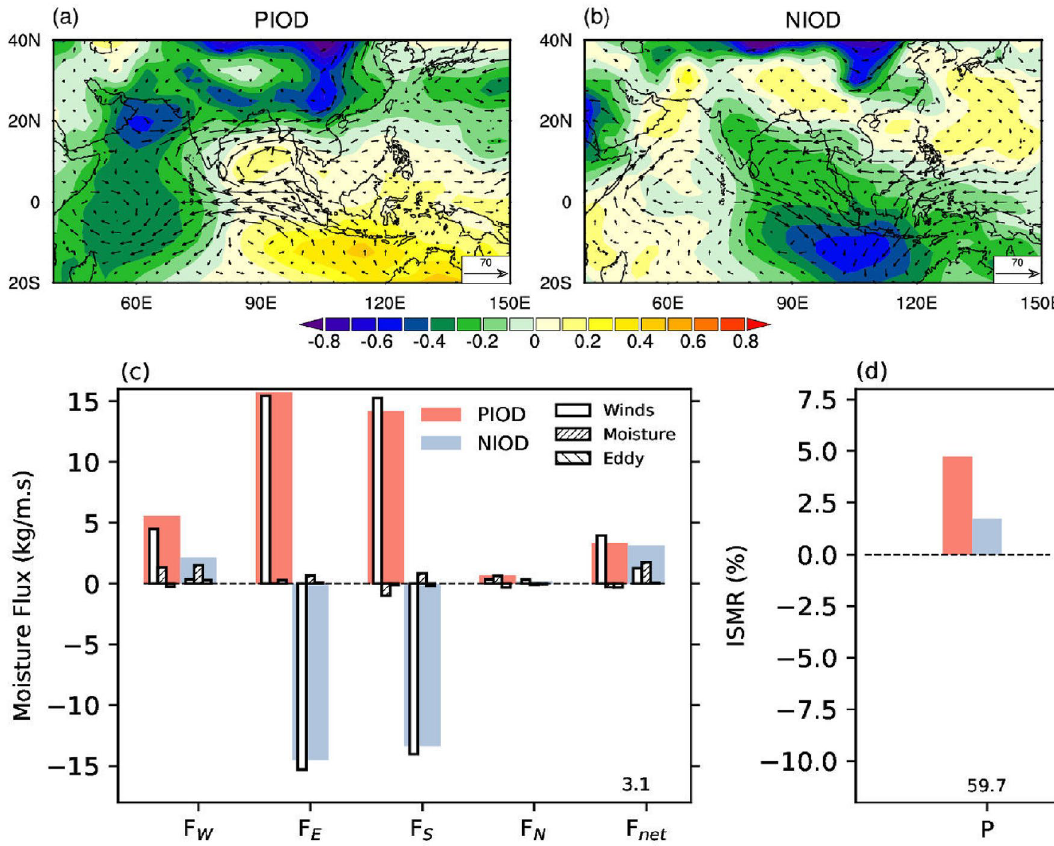
Figure 4. The teleconnection to Indian Ocean Dipole (IOD). Composite change in the anomalous surface pressure (hPa) and vertically integrated moisture flux vector ( kgm − 1 s − 1 ) during ( a ) positive (PIOD) and ( b ) negative (NIOD) phases. ( c ) Shows the vertically integrated moisture flux anomalies and its decomposition along the four boundaries (west ( F W ), east ( F E ), south ( F S ), and north ( F N )) and net moisture convergence ( F net ) over region marked as ABCD in Fig. 1a, for PIOD (red) and NIOD (blue) years. The contribution to total ¯(cid:3) Vq (cid:4) (cid:5) ), and eddy flux ( (cid:2)(cid:3) V (cid:4) q (cid:4) (cid:5) ). moisture flux (solid fill) and its components: due to winds ( (cid:2)(cid:3) V (cid:4) ¯ q (cid:5) ), moisture ( (cid:2) ( d ) The corresponding change in the Indian summer monsoon rainfall (ISMR) during PIOD and NIOD. The number along F net and P represents the significance level at which the hypothesis that means are the same for IOD years is rejected. We regress out the impact of ENSO from all variables shown in this plot. This figure was created using NCL version 6.4.0 (https:// www. ncl. ucar.